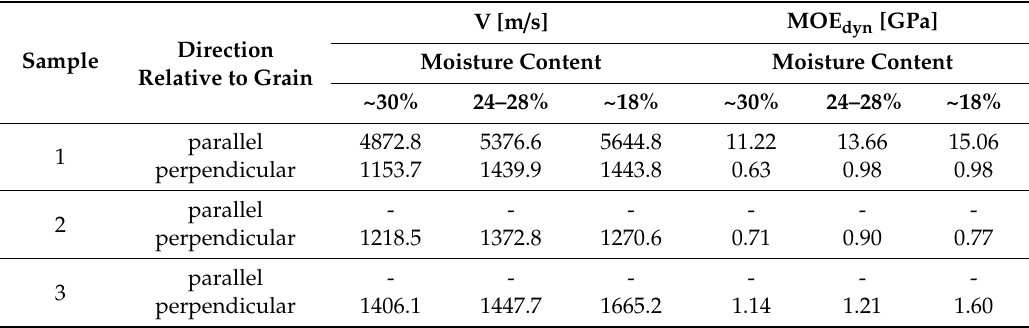
Table 8. Fakopp Microsecond Timer test results: velocity of stress wave propagation and dynamic modulus of elasticity depending on moisture content and direction relative to grain.